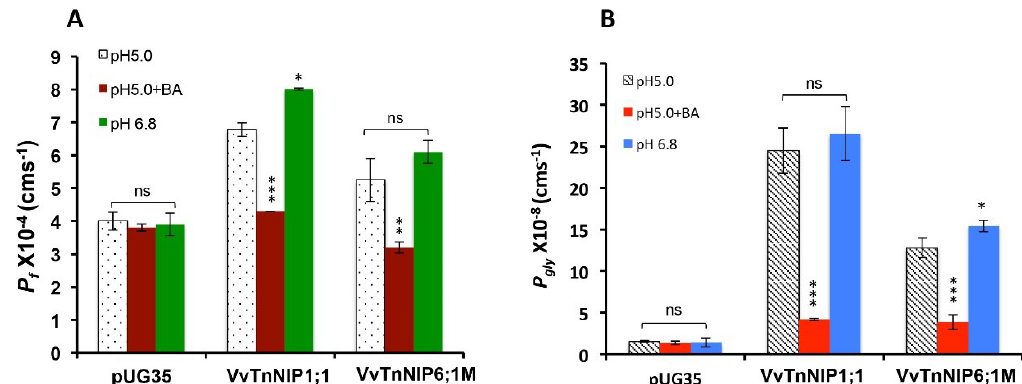
Figure 6. pH‐dependent ( A ) water and ( B ) glycerol permeabilities of grapevine NIPs. Permeability coefficients were measured at extracellular pH 5.0 (pH in 6.1), pH 5.0 + 4.0mM benzoic acid (BA) (pH